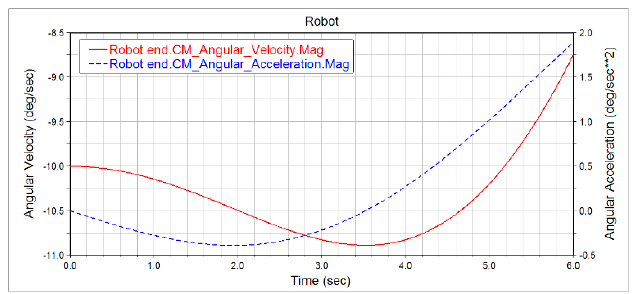
Figure 10. End angular velocity/angular acceleration curve.